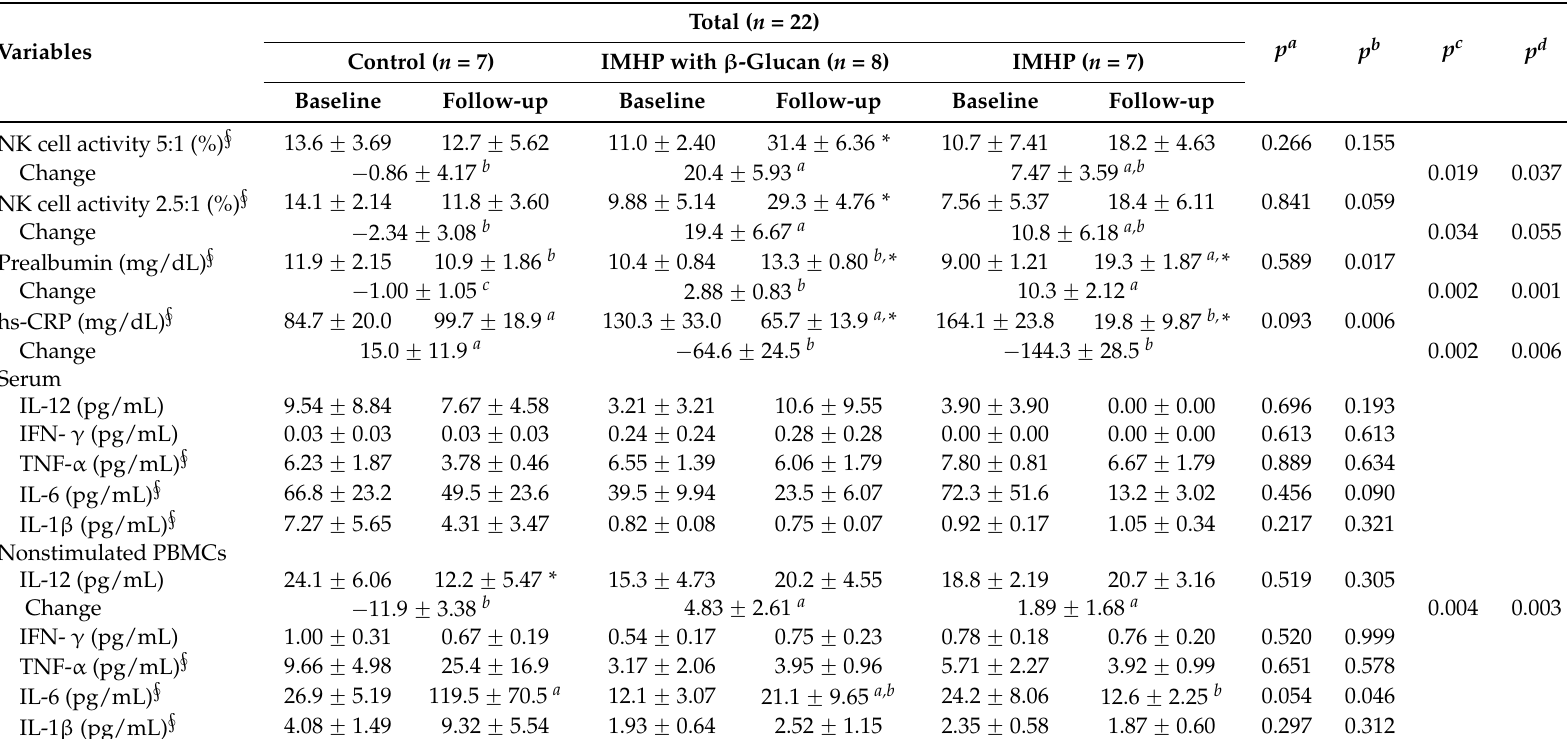
Table 3. NK cell activity, prealbumin, serum, and PBMC cytokines in the control and the IMHP groups with and without β